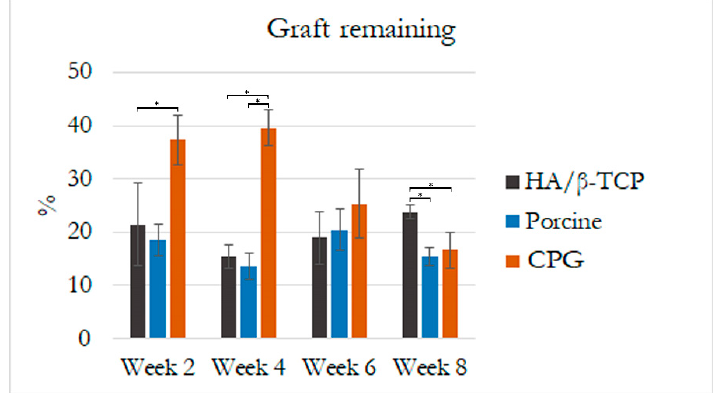
was measured in the regions of interest (2 mm × 2 mm) at the borders and center of the most central part of the rabbit calvaria defects. Asterisks (*) indicate statistically significant differences ( p < 0.05).